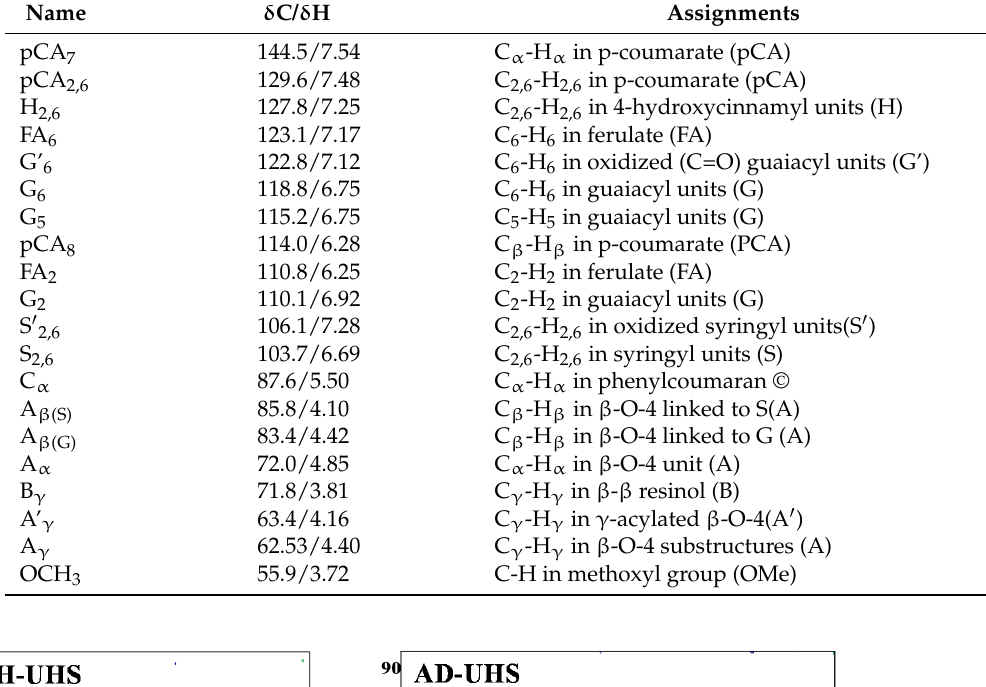
Table 6. The assignments of major components in the HSQC NMR spectra.